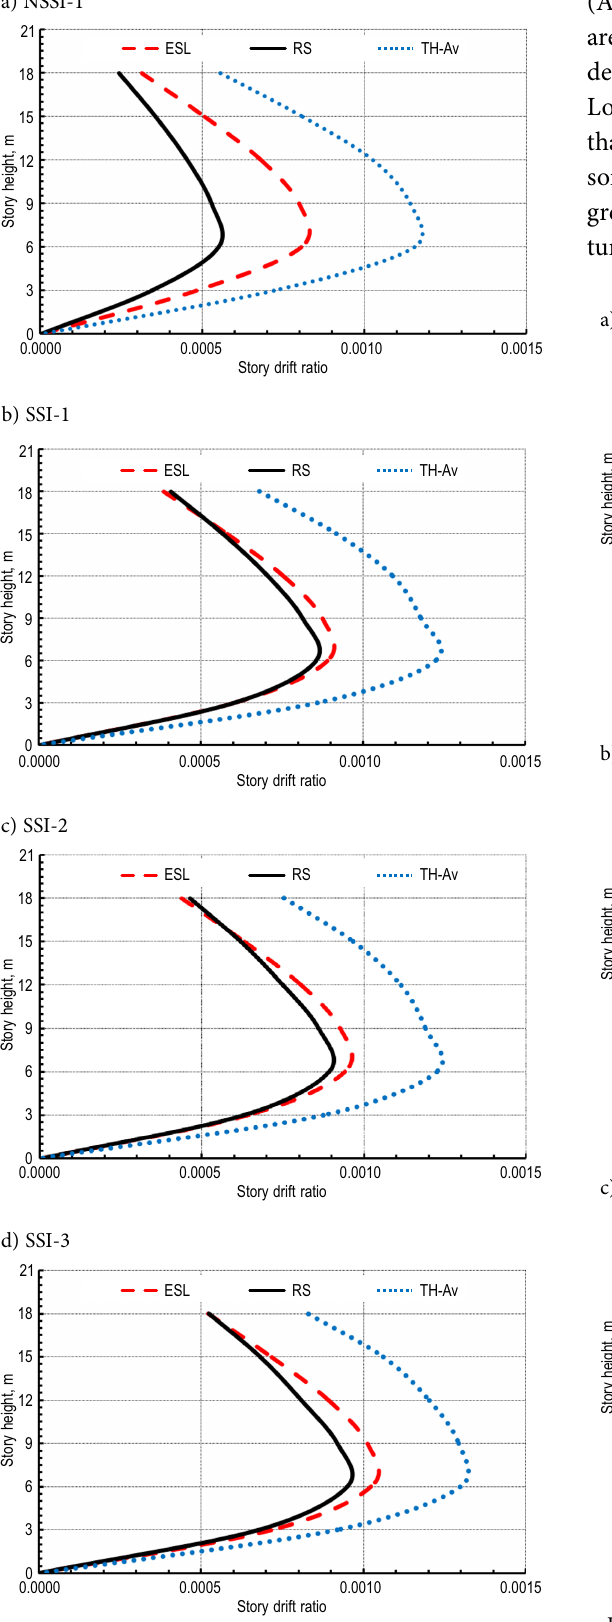
Fig. 4. Story drift ratio of 6-story models